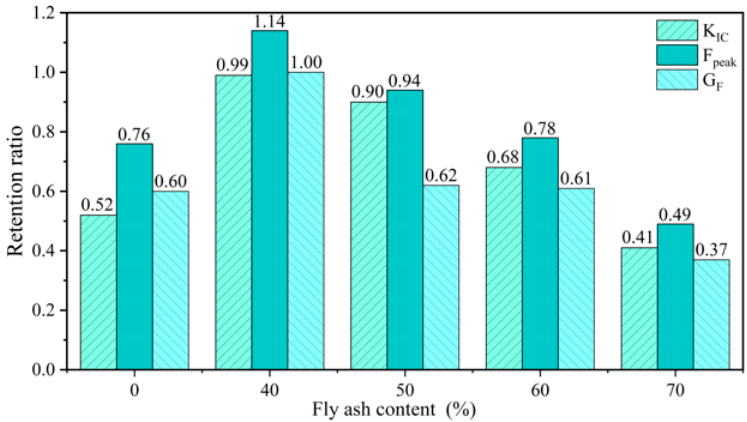
Figure 7. The fracture parameter retention ratio of SFSCC.